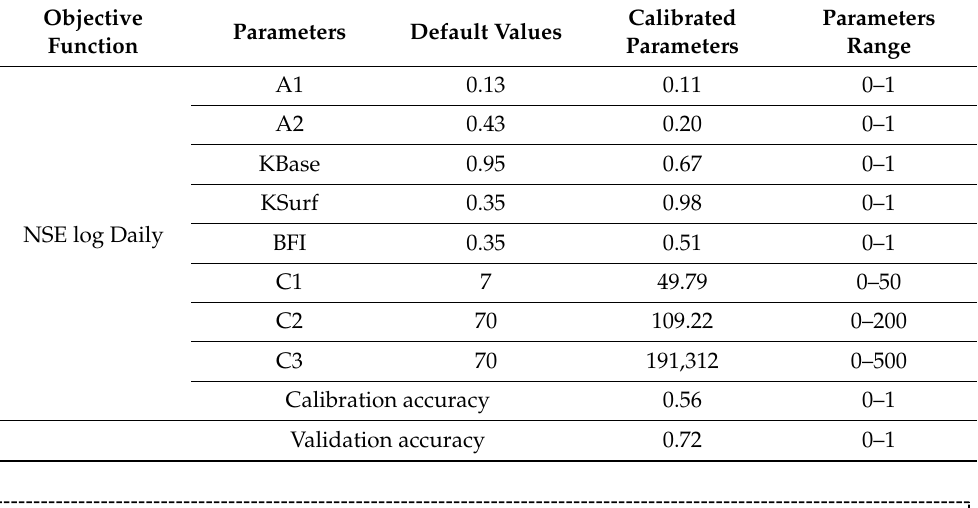
Table 5. Calibrated parameters of the AWBM rainfall–runoff model.